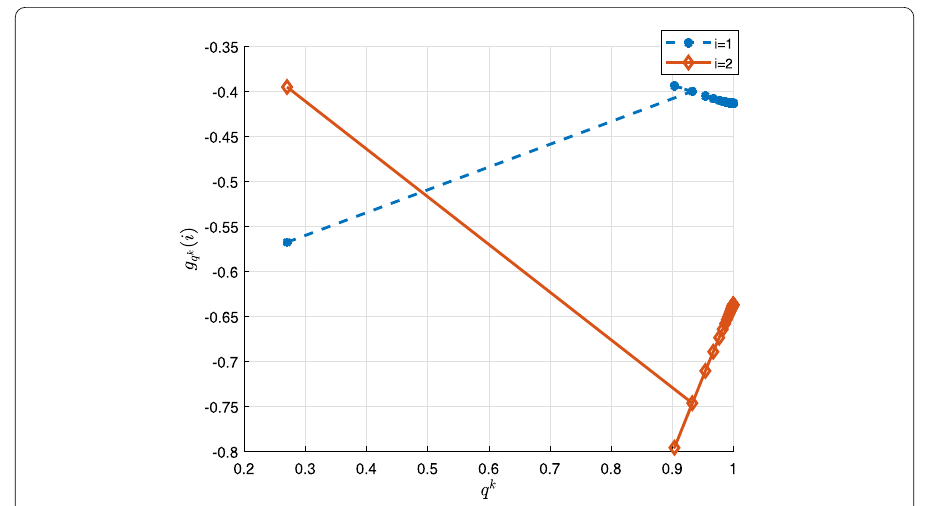
Figure 1 Graphical representation of the q -gradient of Mishra 6 function based on Table 1